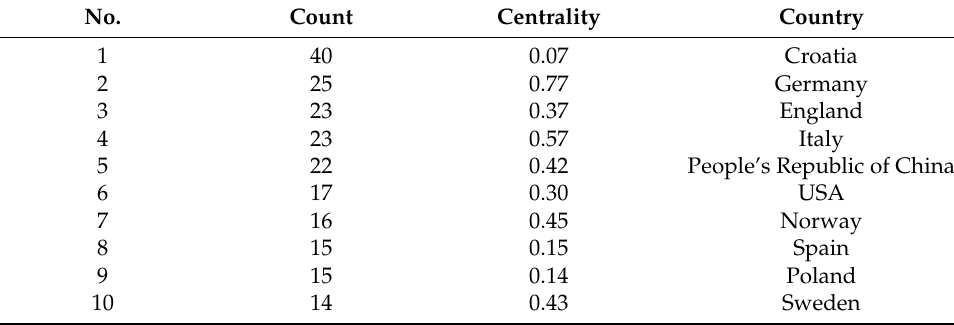
Table 2. Top 10 countries based on publications.